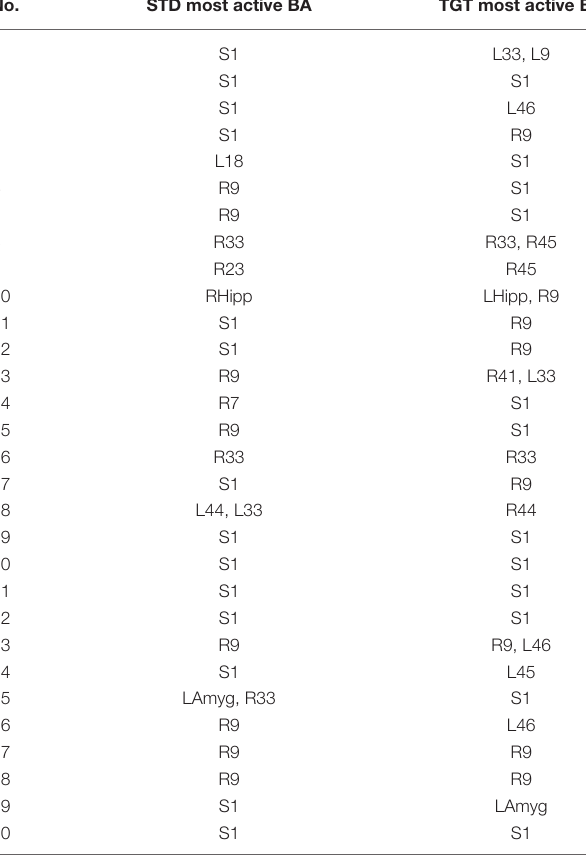
TABLE 4 | The ι for the most active BA in particular subjects of the control group during the P300 experiment for the STD and TGT responses obtained from the sLORETA quantitative